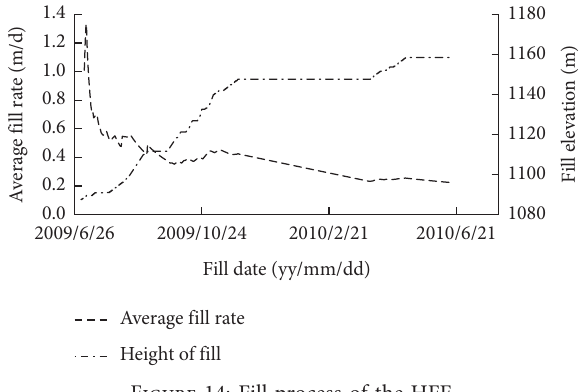
Figure 14: Fill process of the